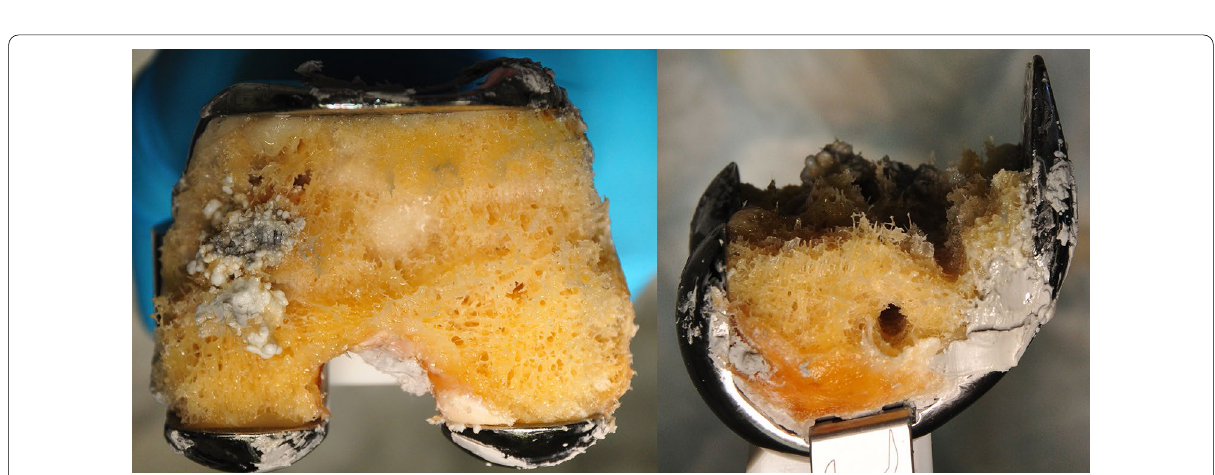
Fig. 6 Specimen failure following pull-out testing. Example of the failure mode in the metaphyseal part of the distal femur with the femoral component still connected to the most distal part of the